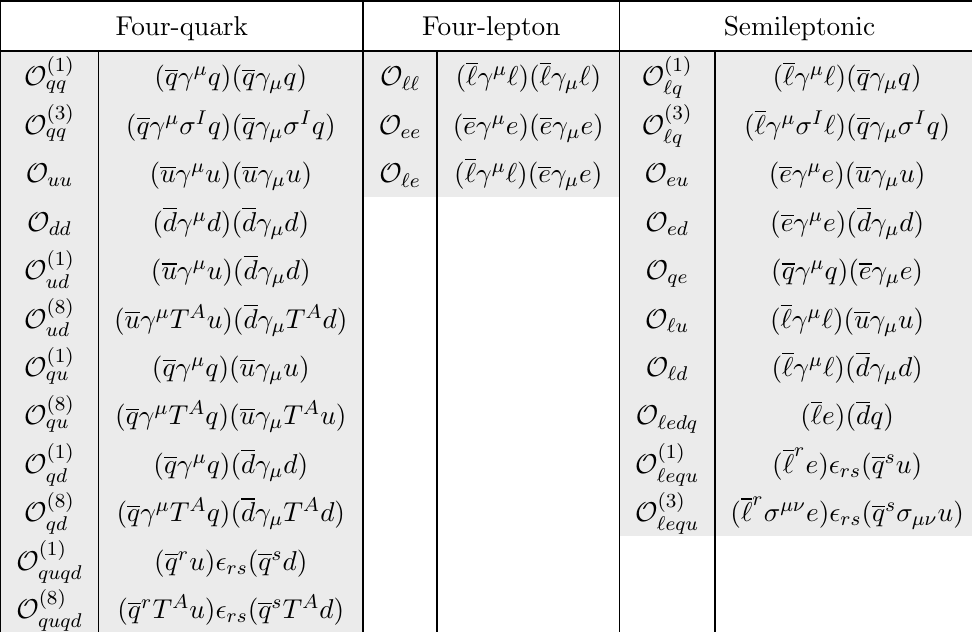
Table 3 . Baryon and lepton number conserving four-fermion operators. All operators are included in Warsaw basis. Fermion family indices are omitted. Indices r; s; p; t; : : : denote the SU(2) L fundamental representations.